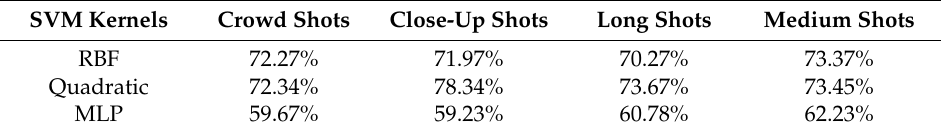
Table 6. Classification accuracy using SVM (Quadratic, MLP and RBF kernels) with